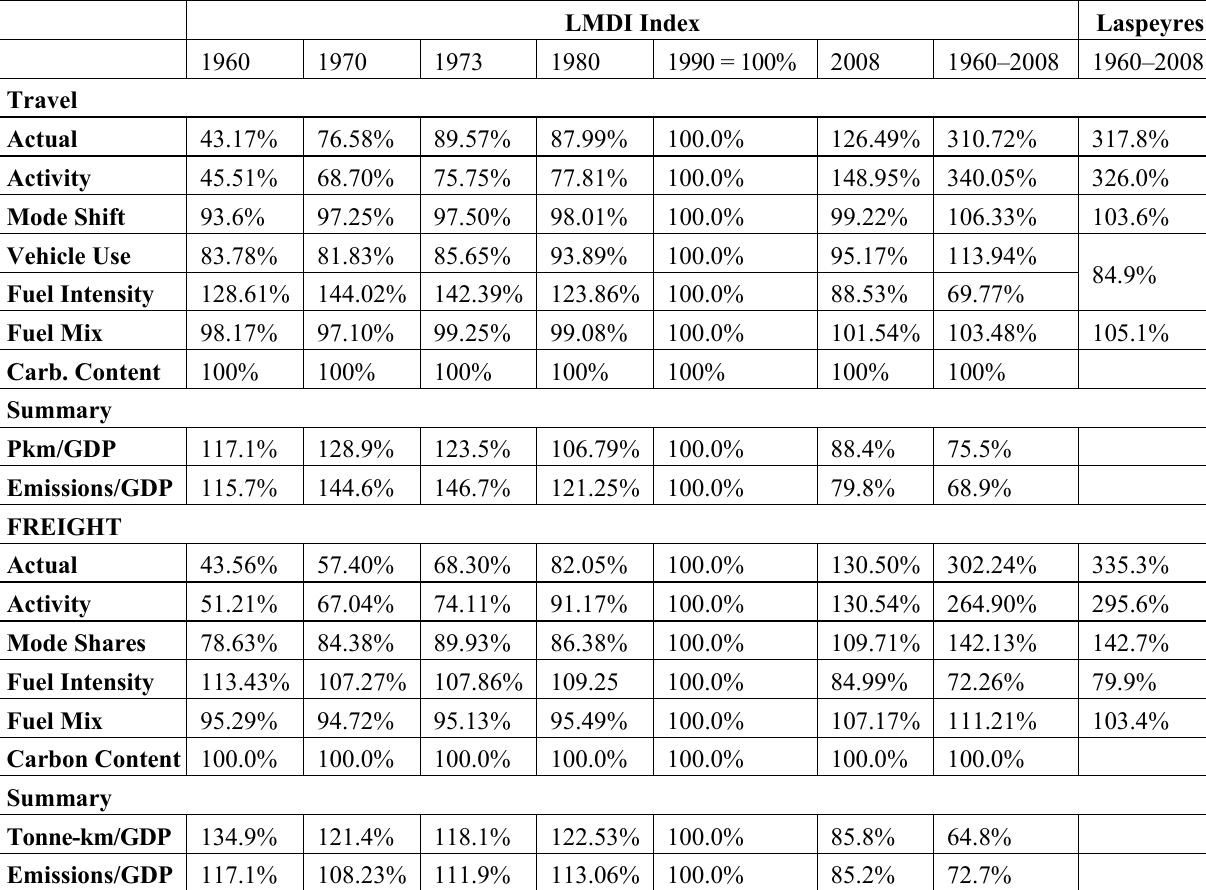
Table 1. Decomposition of Changes in Carbon Emissions from Travel and Freight,